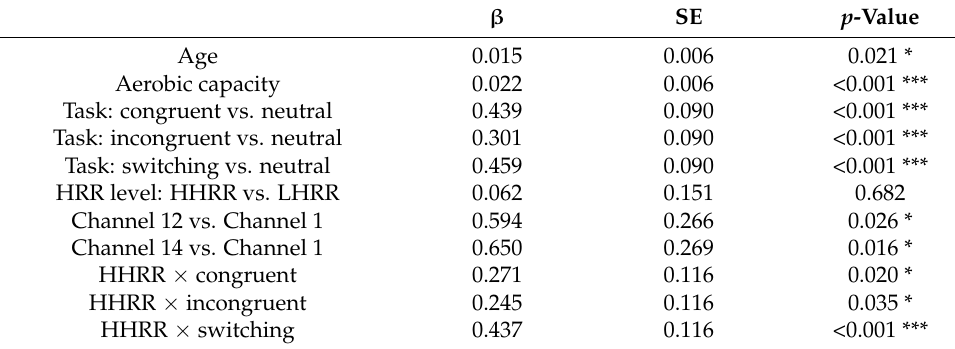
Figure 3. Prefrontal cortical activation differences, as measured by ( A ) mean oxygenated hemoglo ‐ bin (HbO 2 ) and ( B ) mean deoxygenated hemoglobin (Hb) levels across all 16 optodes between lower heart rate reserve (LHRR) and higher heart rate reserve (HHRR) groups across Modified Stroop Color Word Test (MSCWT) tasks. Table 3. Linear mixed effect models with heart rate reserve (HRR) level and Modified Stroop Color Word Test (MSCWT) task conditions as the main effects while controlling for channel, age, and aerobic capacity and HbO 2 as the dependent